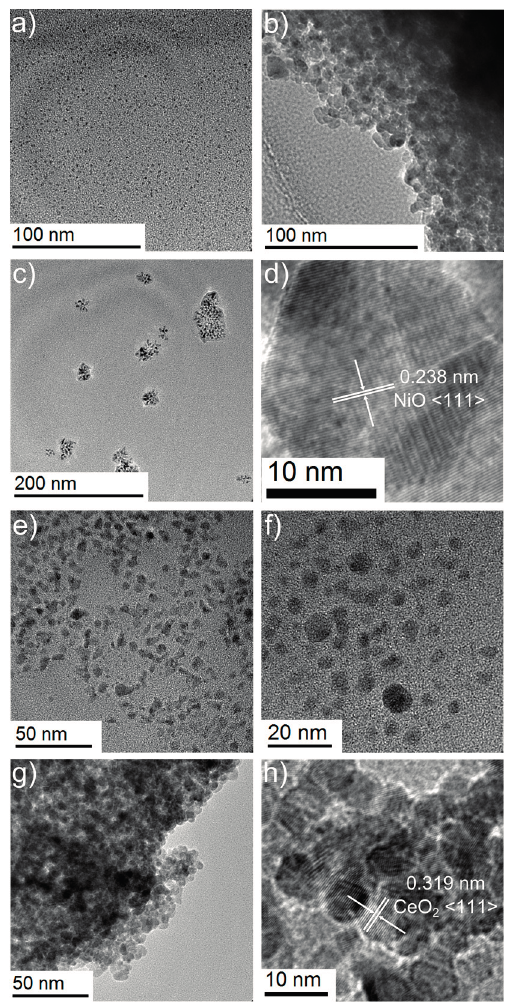
Figure 1. TEM images of pre- and post annealed samples. ( a ) Sample 1 (CeO 2 nanoparticles); ( b ) Sample 1 (annealed); ( c ) Sample 2 (NiO nanoparticles); ( d ) Sample 2 (annealed) showing a d -spacing of 0.238 nm assigned to the <111> plane of NiO; ( e ) Sample 3 (50% Ni-CeO 2 ); ( f ) Sample 7 (4% Ni-CeO 2 ); ( g ) Sample 9 (2% Ni-CeO 2 , annealed) and ( h ) Sample 5 (8% Ni-CeO 2 , annealed) showing showing a d -spacing of 0.238 nm assigned to the <111> plane of CeO 2